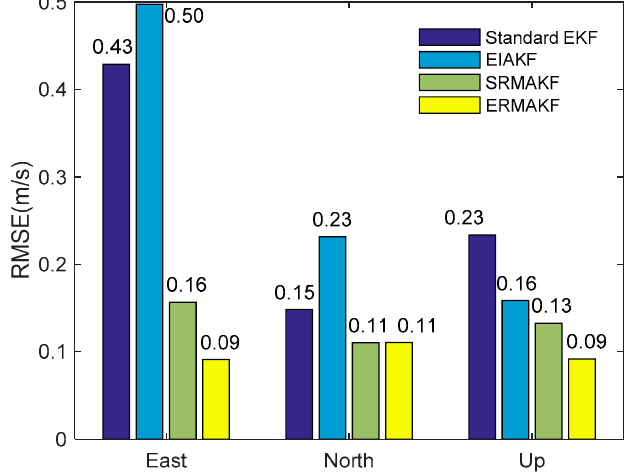
Figure 8. Comparison of position root mean square error (RMSE) for different algorithms.